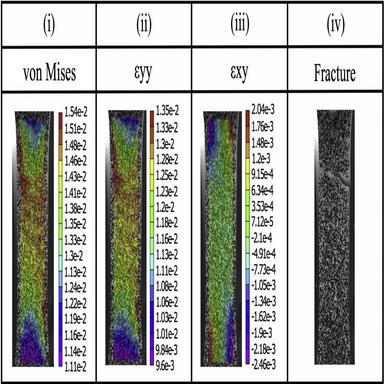
DIC strain fields on ABS-20GF specimens at an instant before rupture.